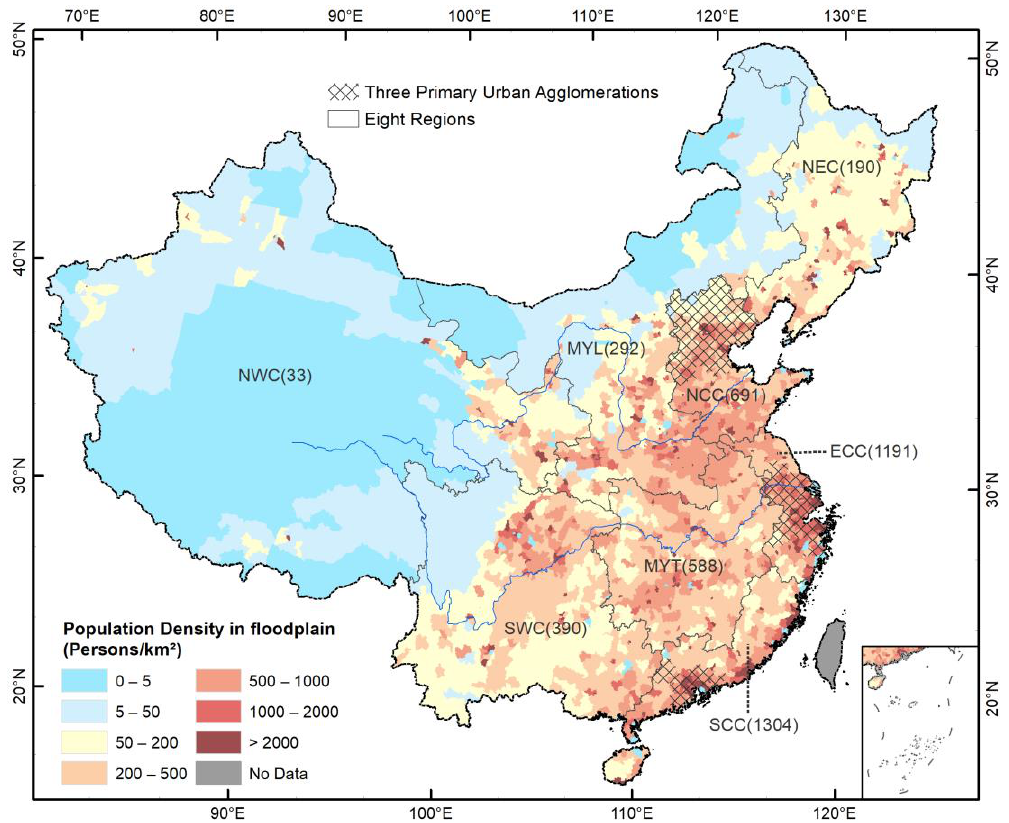
Figure 2. Density of population in the floodplain in China in 2015. Note: numbers in bracket are the average density for regions (in people/km 2 ); refer to Figure 1 for the abbreviations of the regions.